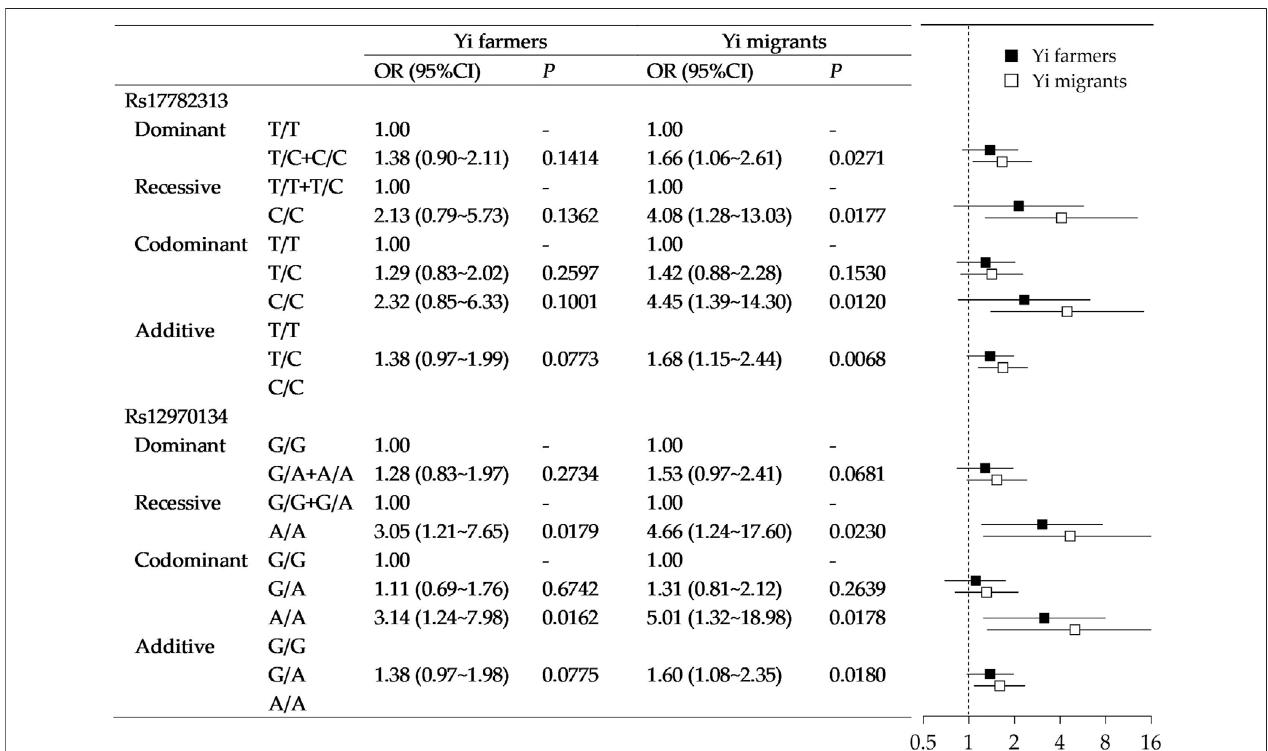
FIGURE 3 | Association of MC4R gene polymorphisms with obesity in Yi farmers and Yi migrants. Note that the models were adjusted for age, sex, education, income, smoking status, drinking status, occupational physical activity, and leisure-time exercise.